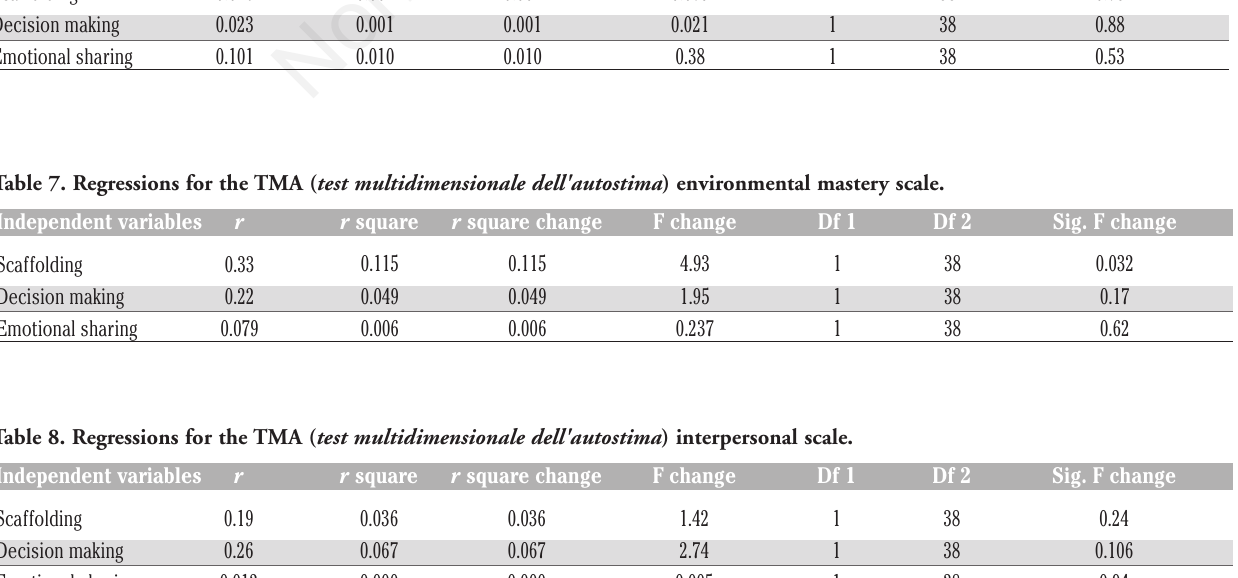
Table 6. Regressions for the TMA ( test multidimensionale dell'autostima ) emotional scale. Independent variables r r square